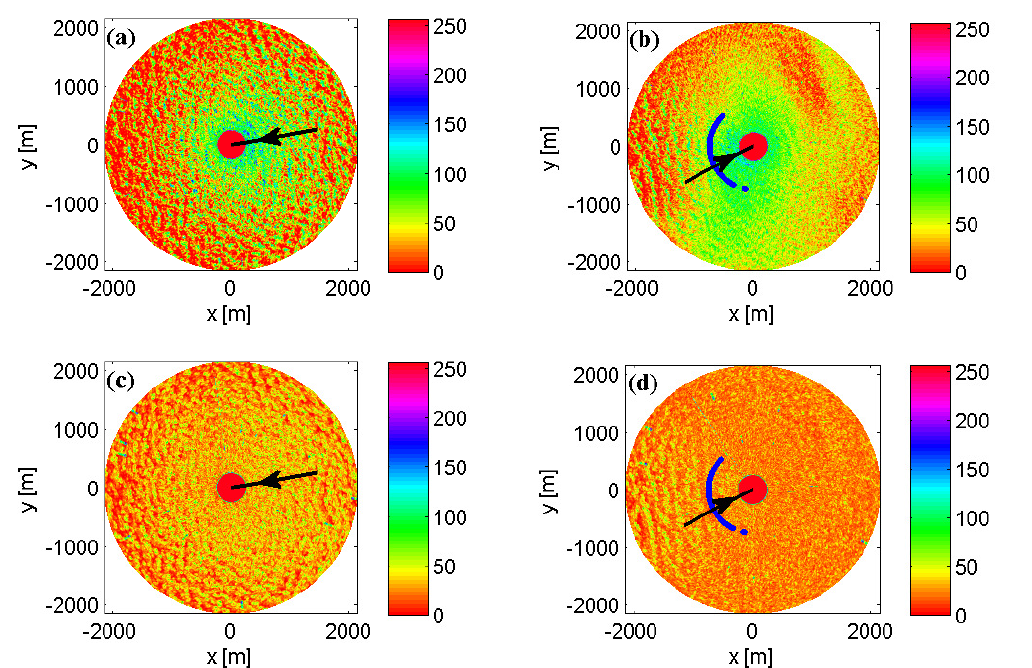
Figure 1. Examples of marine radar images and the their texture maps: ( a ) radar image without rain-contamination; ( b ) rain-contaminated radar image; ( c ) texture map of ( a ); ( d ) texture map of ( b ). The arrow indicates the direction from which the wind blows, and the blue ring in ( c , d ) denotes the azimuthal direction in which the image portion is less affected by rain. The ZPP and RPP values of ( a ) are 23% and 0%, respectively. The zero pixel percentage (ZPP) and rain rejection percentage (RRP) values of ( b ) are 1% and 68%,